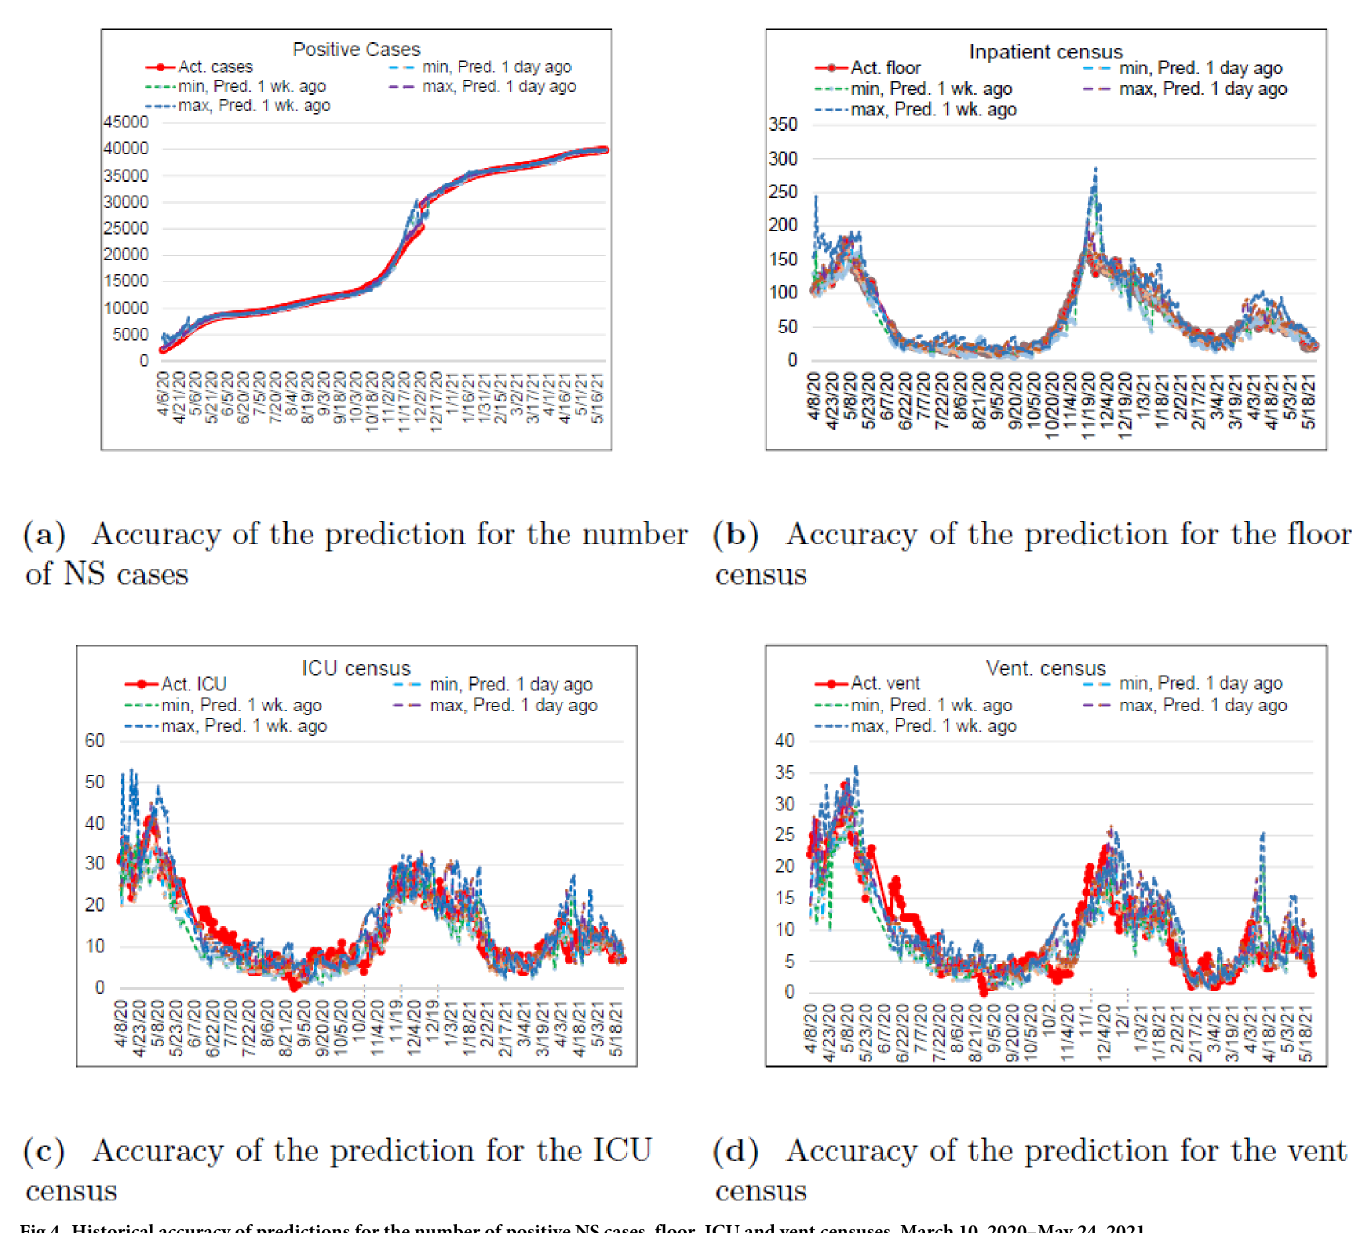
Fig 4. Historical accuracy of predictions for the number of positive NS cases, floor, ICU and vent censuses, March 10, 2020–May 24, 2021.